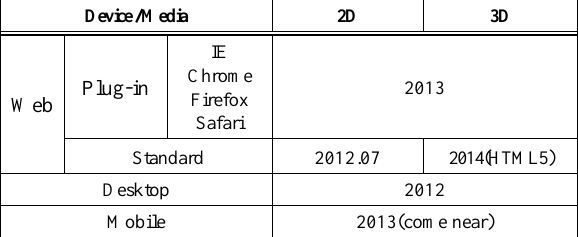
Table 3. Service Situations and Future Plans according to Device and Media